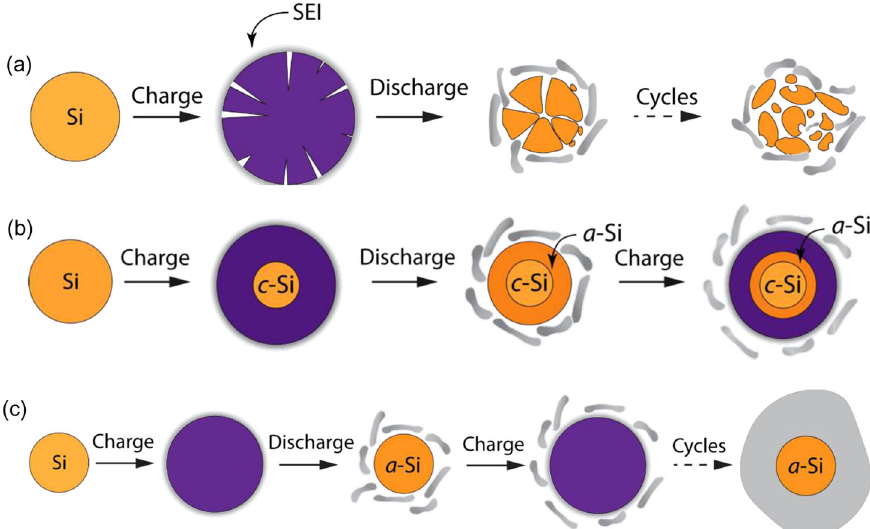
Fig. 1 Degradation mechanisms of large-volume-change anodes in LIBs. a Fracture and pulverization of high-capacity electrode materials. b Lithiation retardation due to compressive stress reduces rate performance and lowers the effective capacity. c Large volume changes induce unstable SEI growth on the electrode